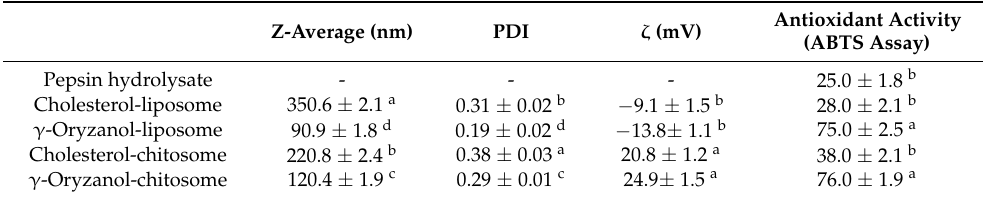
Table 3. Physical stability of hydrolysate-loaded γ -oryzanol-liposomes and chitosomes during one month at 4 ◦